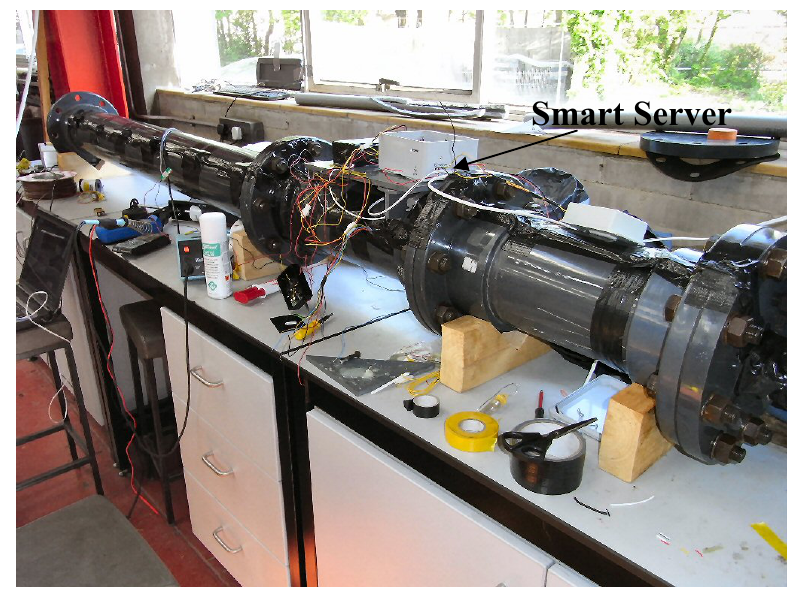
Figure 2. Smart pipe demonstrator unit before